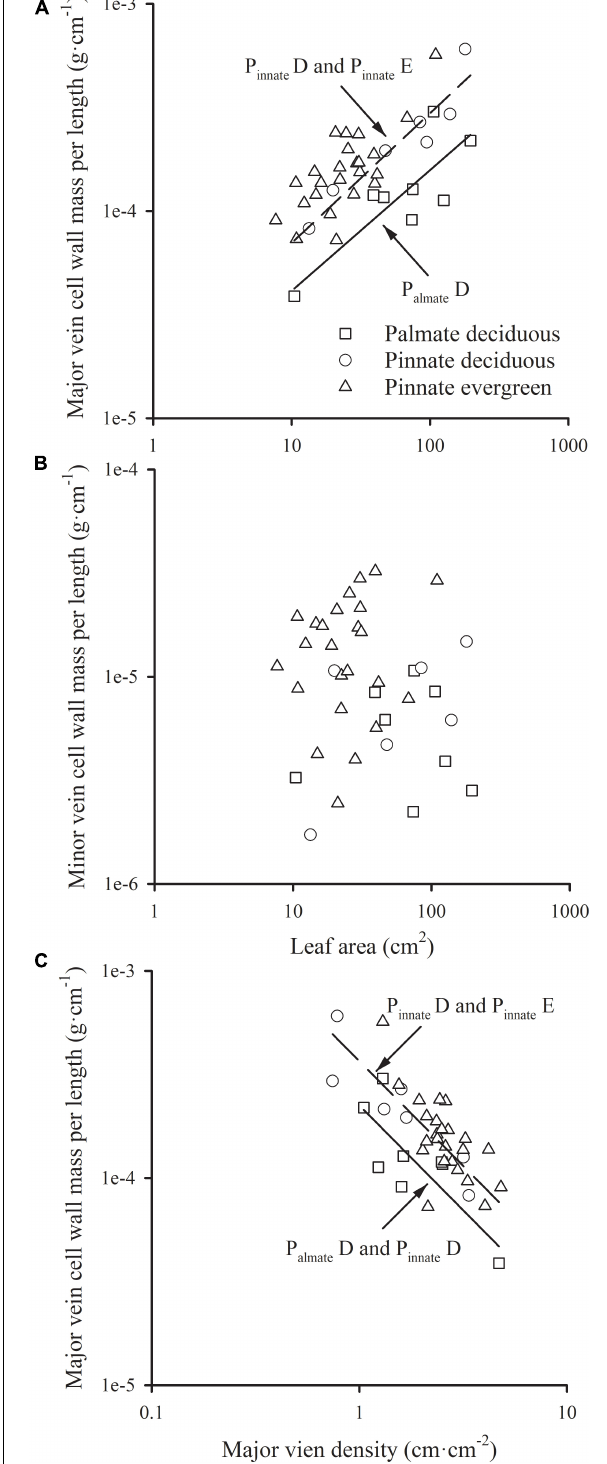
FIGURE 2 | The relationships of the cell wall mass per length of the major vein (A) , and that of the minor vein (B) with leaf area; the relationship of the cell wall mass per length of the major vein with the major vein density (C) . For abbreviations, see Figure 1